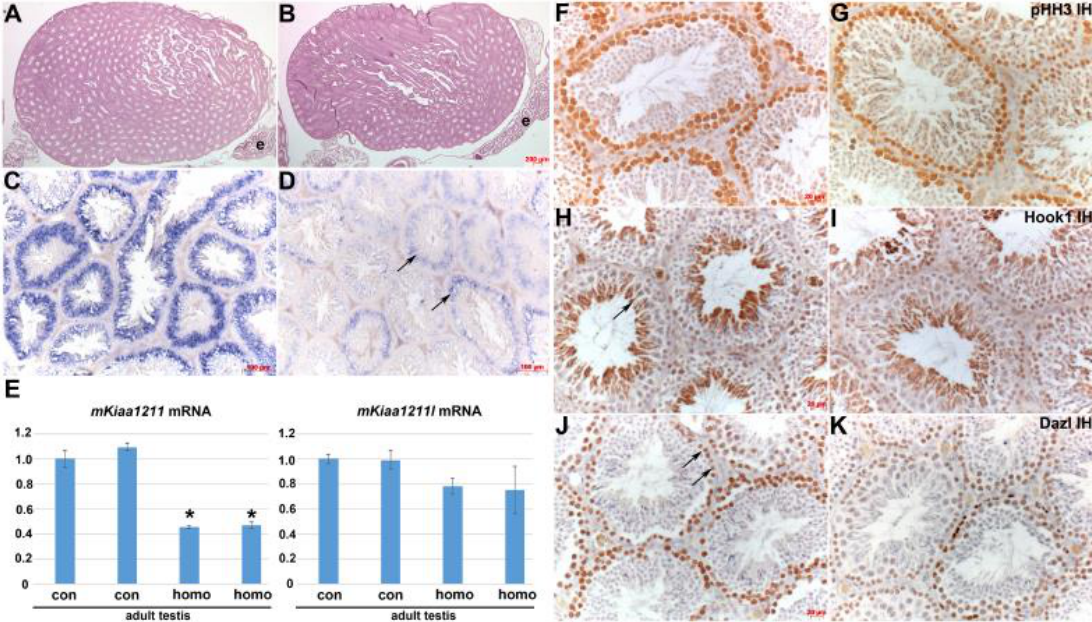
Figure 5. Analysis of mKiaa1211 mouse mutant phenotype. ( A , B ) Using CRISPR-generated mKiaa1211 mouse mutant ( C530008M17Rik em1(IMPC)J/ J ) mice, histology showed that mKiaa1211/mKiaa1211 homozygous adult testis and epididymis were grossly normal ( B ) when compared to age-matched littermate controls ( A ). ( C , D ) Non-radioactive in situ hybridization detection of mKiaa1211 revealed homozygous mutant testis exhibits significantly reduced mRNA levels (arrows ( D )) when compared to controls ( C ), despite similar patterns of expression. ( E ) Quantitative PCR analysis confirmed that duplicate mKiaa1211/mKiaa1211 homozygous adult testis express ~60% less mKiaa1211 mRNA levels (indicated by *) but that mKiaa1211L levels are unaffected, when compared to age-matched littermate controls. ( F , G ) Homozygous proliferating spermatogonia (identified using pHH3 antibody) were detected in roughly equal numbers. ( H–K ) Immunohistochemistry verified that homozygous mutant ( I , K ) and control (arrows ( H , J )) testis express equivalent cytoplasmic Hook1 protein in spermatids, as well as Dazl protein in spermatogonia nucleus. Scale bars: ( A , B ) = 200 µm; ( C , D ) = 100 µm; ( F – K ) = 20 µm. Abbreviations: e — epididymis.